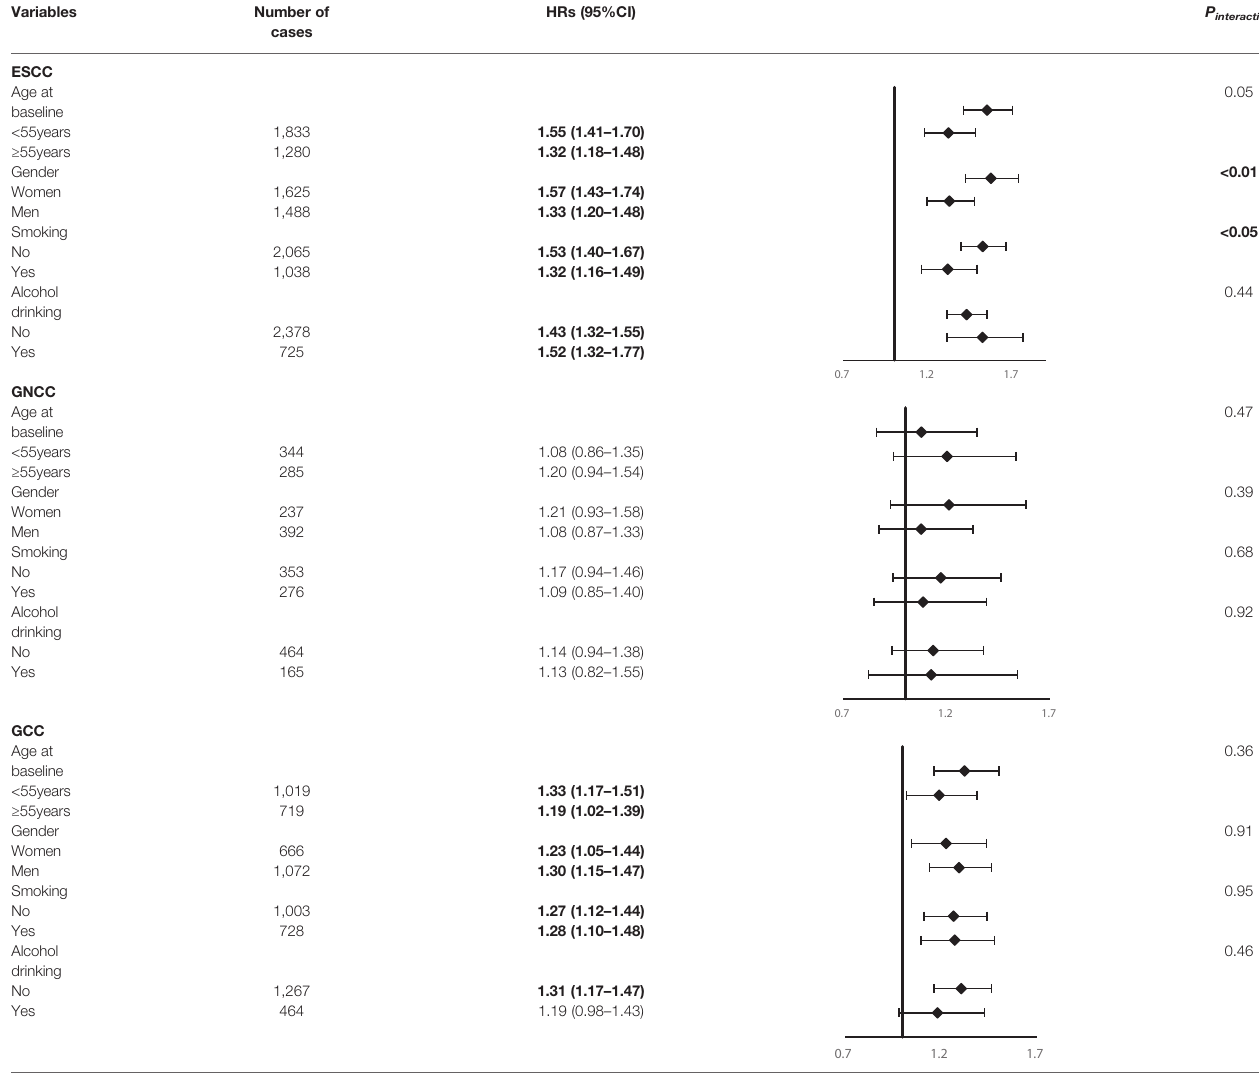
TABLE 4 | Subgroup analyses for family history of UGI cancer and risk of ESCC, GCC and GNCC incidence Variables P